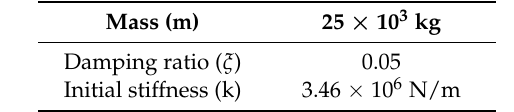
Table 1. The dynamic parameters of the used building